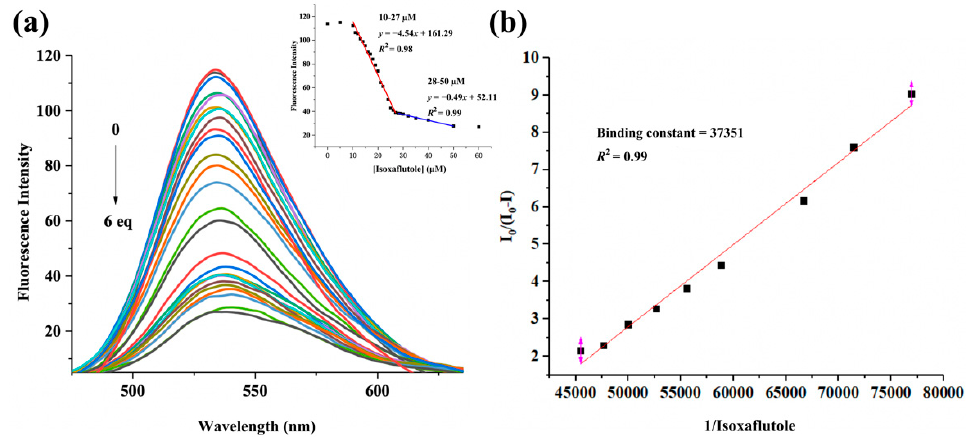
Figure 7. ( a ) Fluorescence spectra recorded for probe MMN (10 μ M) upon spectrometric titration with isoxaflutole (0–60 μ M). Inset: The relationship between the fluorescence intensity and the concentration of isoxaflutole. ( b ) Stern–Volmer plot of MMN between MMN and isoxaflutole.